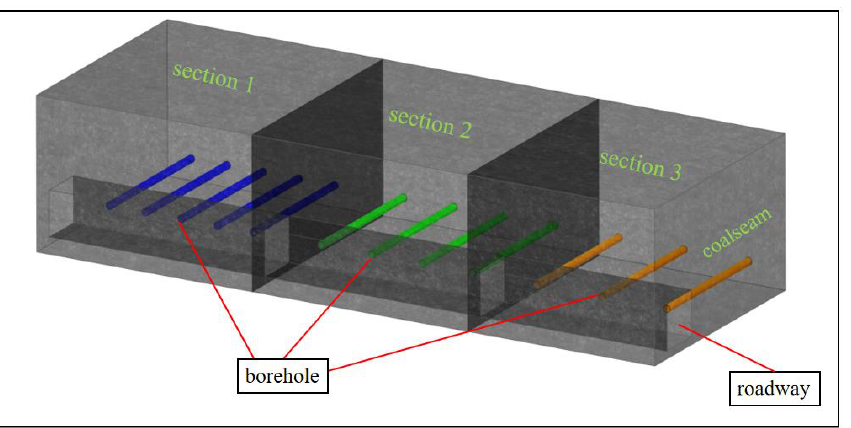
Figure 3. Schematic diagram of differential extraction borehole design.